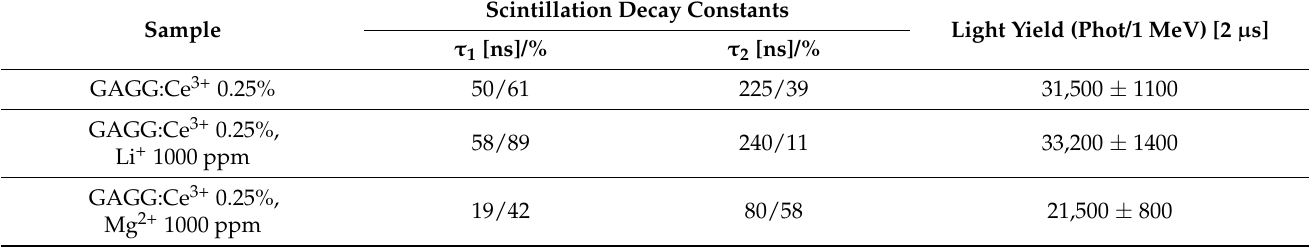
Figure 9. ( a ) Scintillation decay curves and ( b ) pulse-height spectra for Ce 3+ , Ce 3+ :Li + , and Ce 3+ :Mg 2+ doped GAGG single crystals under γ -rays excitation from the 137 Cs radioisotope (662 keV), 300 K. Table 2. Scintillation decay constants and light yield values (shaping time 2 μ s) for Ce 3+ , Ce 3+ :Li + , and Ce 3+ :Mg 2+ doped GAGG single crystals under γ -ray excitation from 137 Cs radioisotope (662 keV), 300 K. Sample